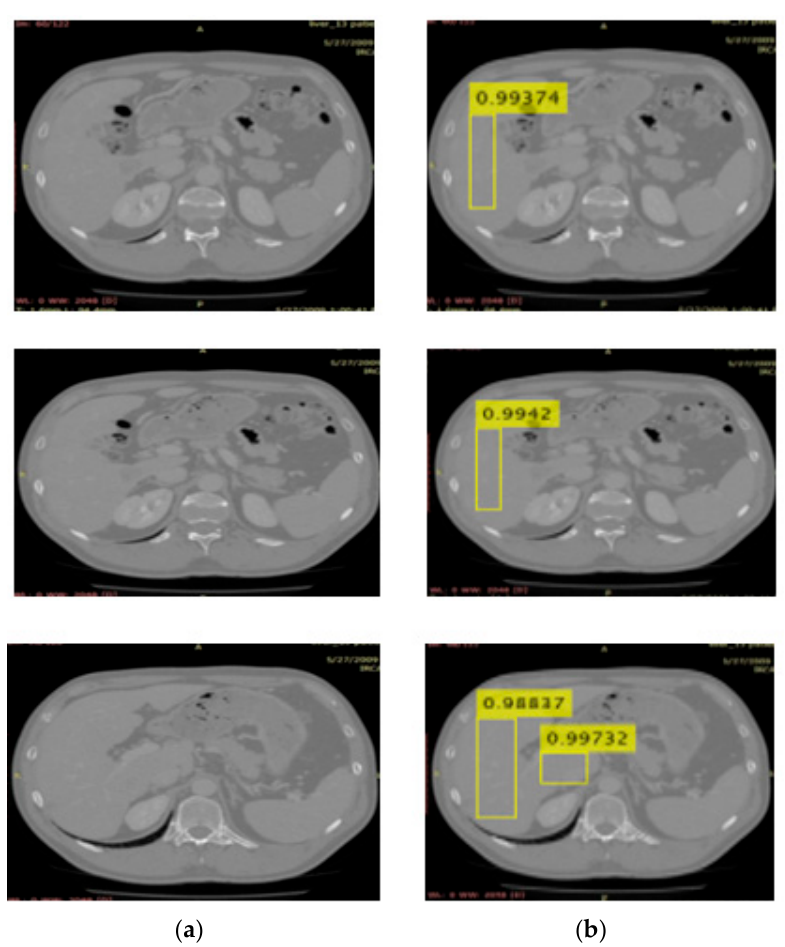
Figure 10. Localization outcomes ( a ) CT input ( b ) localized liver.